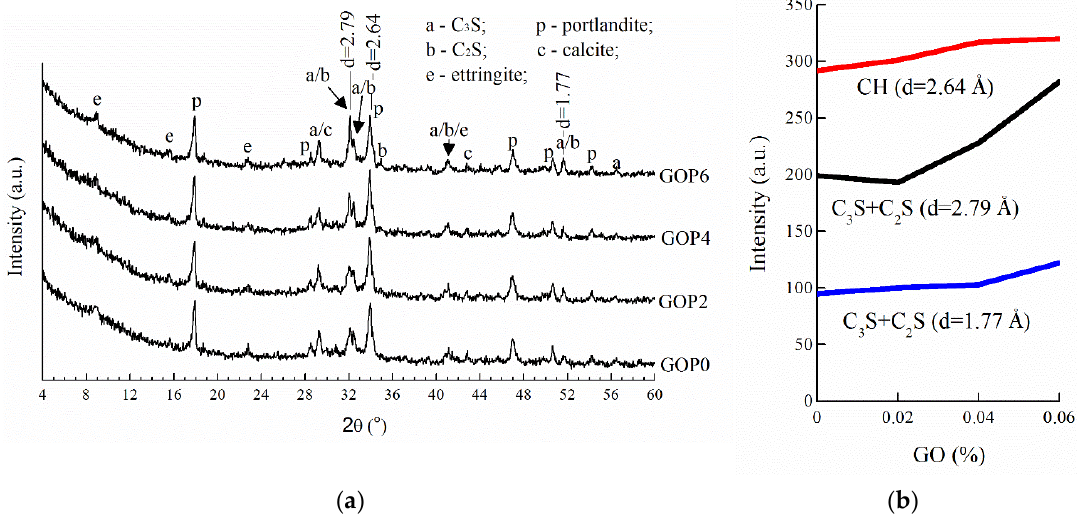
Figure 6. XRD patterns of cement pastes cured for 28 days ( a ), and intensities of main CH, C 3 S and C 2 S peaks as a function of GO dosage ( b ).